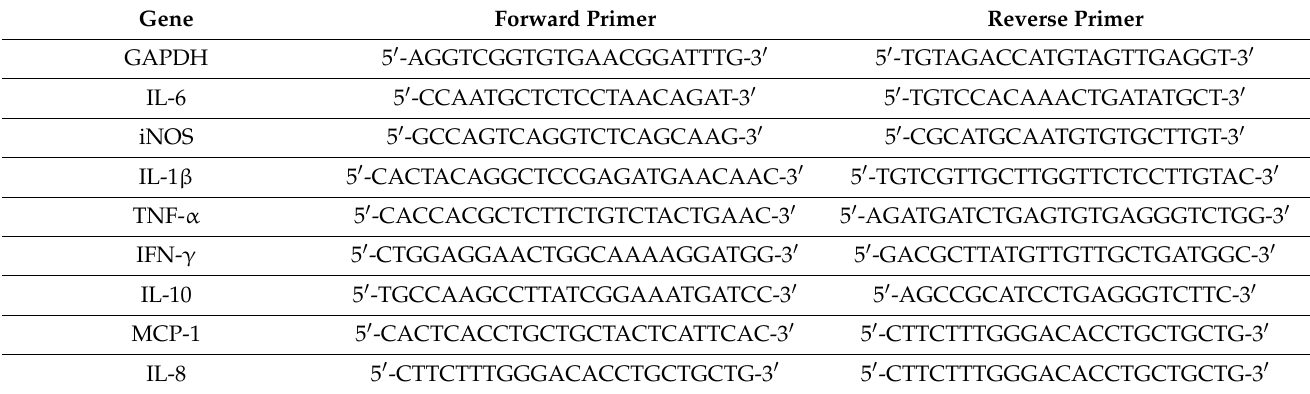
Table 4. Primer sequences (mouse) of inflammatory